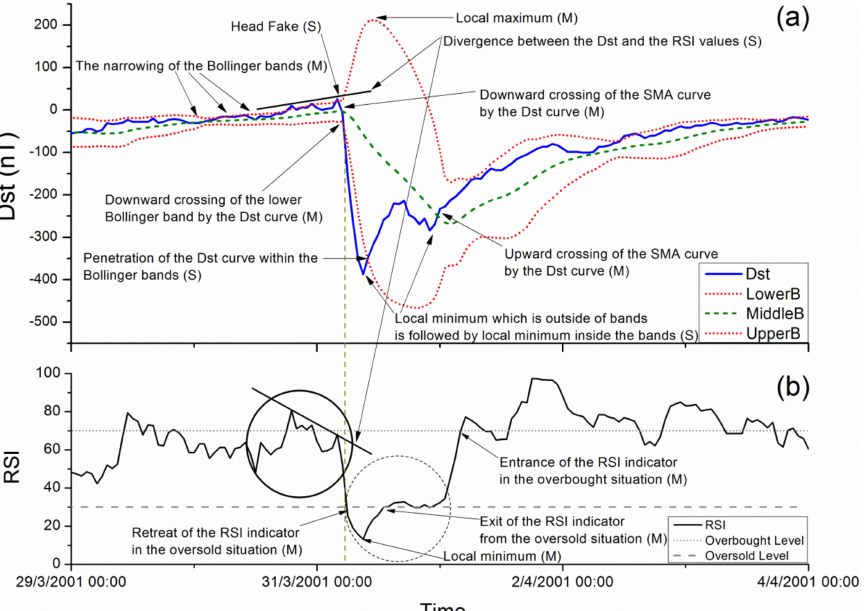
Figure 1. The evolution of an MS in terms of: ( a ) the SMA and Bollinger bands, ( b ) the RSI indicator. The analyses results for a six-day period from 29 March 2001 00:00 (UT) to 4 April 2001 00:00 (UT) are presented as an example. Note that the appearing “(M)” and “(S)” signs refer to the main and secondary features, respectively, as classified in the main text. The areas of the RSI curve, marked by solid and dashed circles, include some secondary features, shown in detail in Figure